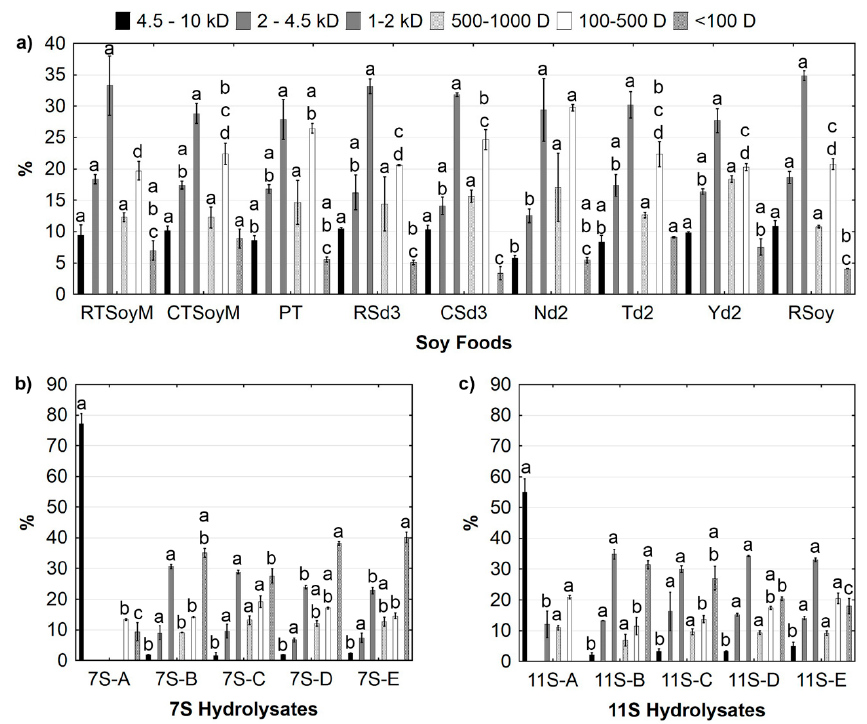
Figure 2. Molecular weight distribution of peptides from the hydrolysates of the simulated in vitro digested soy foods ( a ), 7S protein ( b ), and 11S protein ( c ). RSoy: raw soybean; RTSoyM: raw traditional soymilk; CTSoyM: cooked traditional soymilk; PT: pressed tofu; RSd3: raw sprout germinated